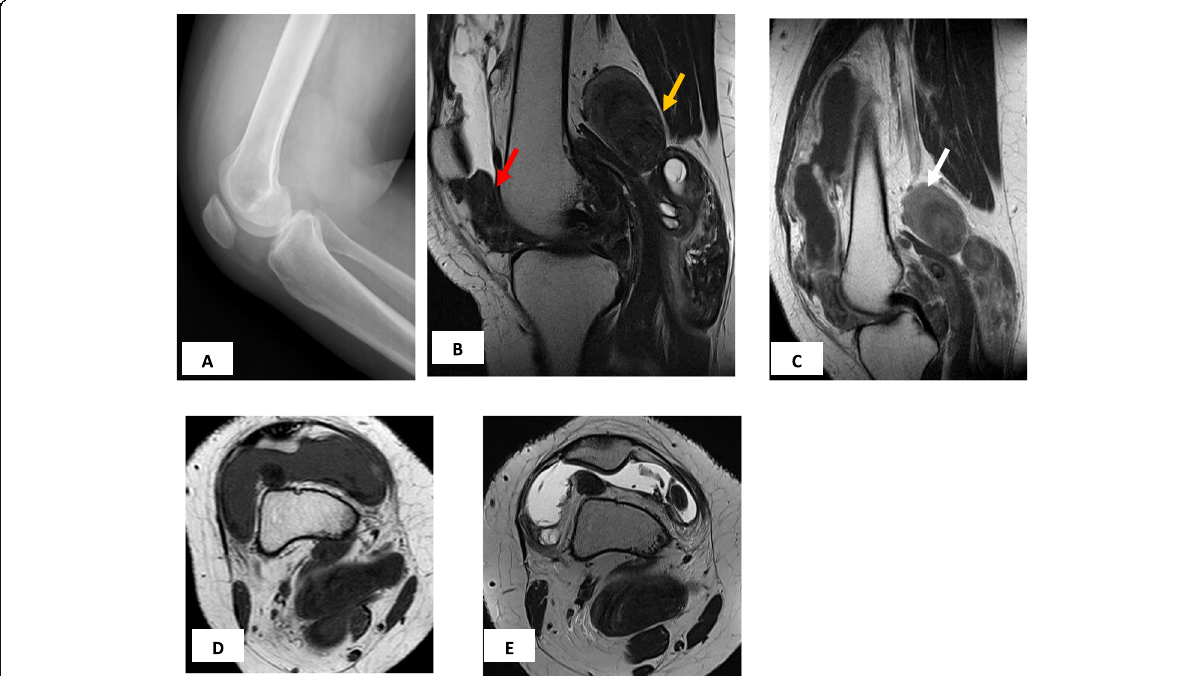
Fig. 5 Right knee diffuse PVNS in 42-year-old female. Lat X-ray ( a ) unremarkable, sagittal T2 ( b ), Sag T1 post-contrast ( c ), axial T1 ( d ), and axial T2 ( e ) show lobulated, mass-like (red arrow) heterogeneous enhanced (yellow arrow) synovial proliferation with characteristic low signal intensity, no articular erosions with large popliteal extra-articular component (white arrow). Sagittal T2 demonstrate massive synovial proliferation with low signal foci of hemosiderin deposition (red